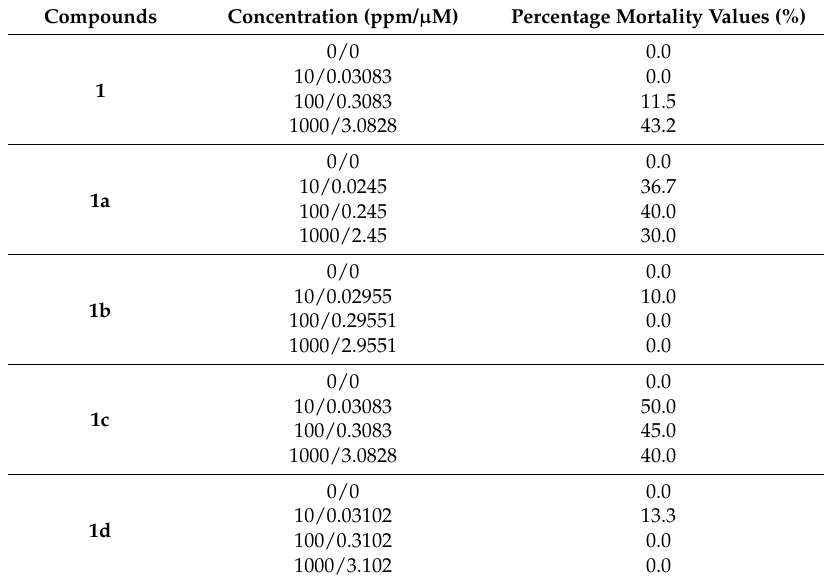
Table 1. Percentage mortality values of natural flavanone 1 and derivatives 1a , 1b , 1c and 1d against Artemia salina .